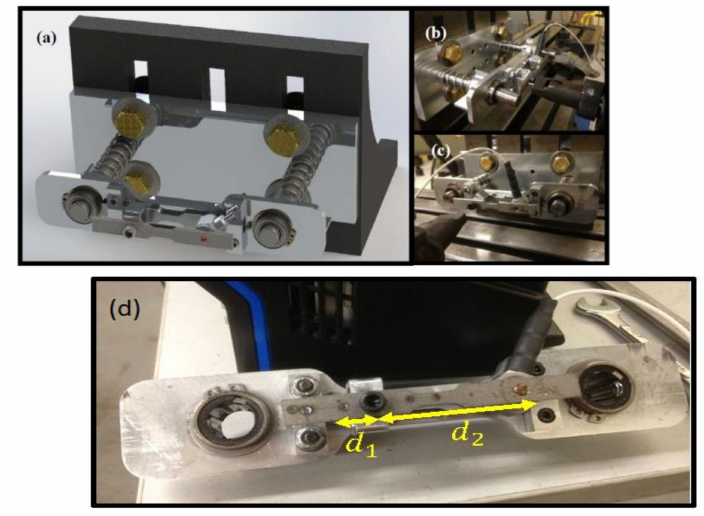
Figure 7. Experimental setup for impact force estimation. ( a – c ) Impact force fixture; ( d ) impact areas and